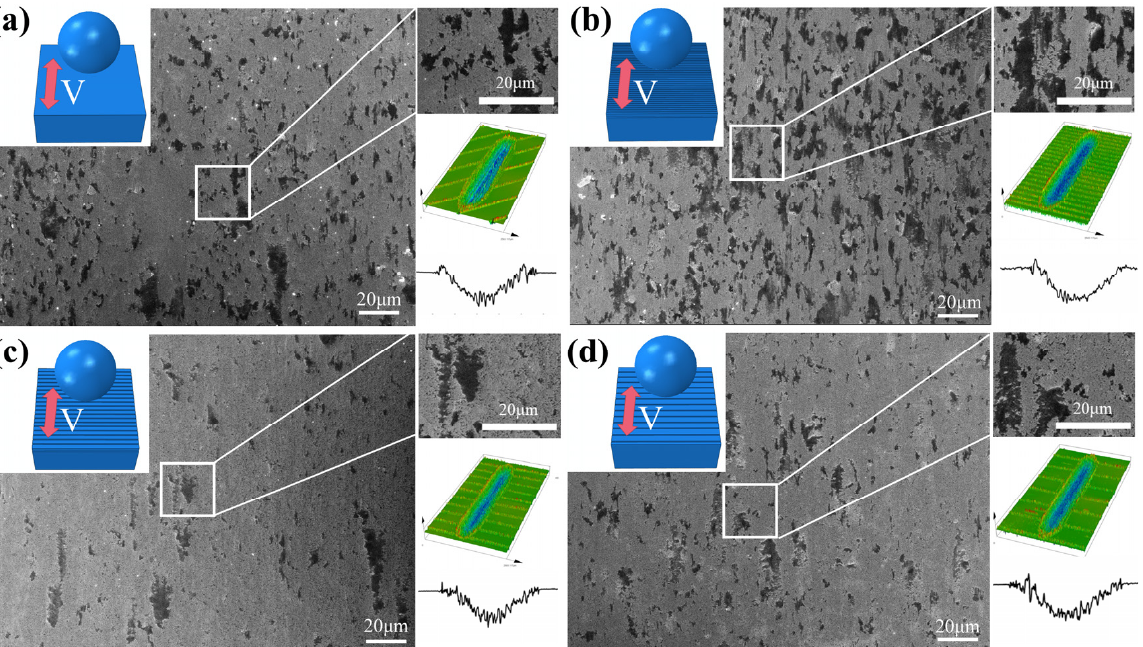
Figure 9. The SEM and LCM morphologies of the worn YG6X surface of ( a ) G0, ( b ) G1, ( c ) G2, and ( d ) G3 under the sliding direction of the Si 3 N 4 ball perpendicular to the groove texture condition.